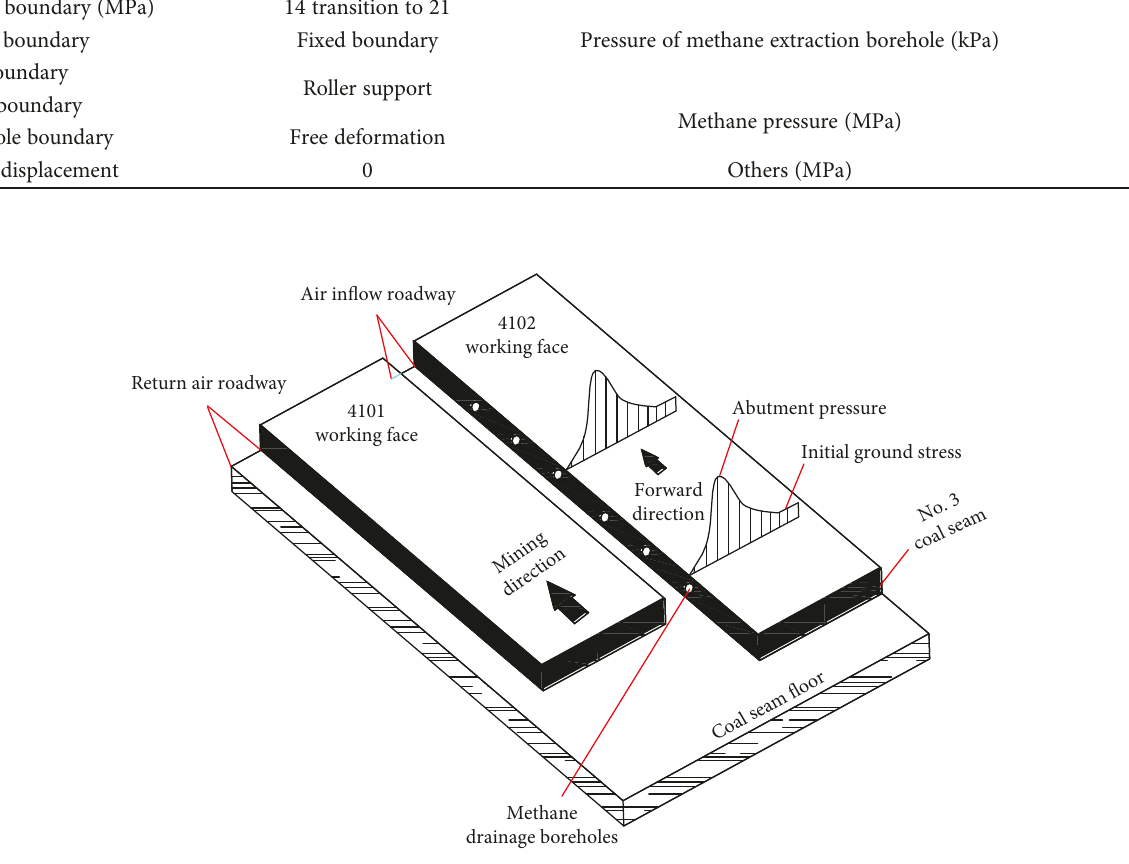
Figure 5: 4102 preparation work